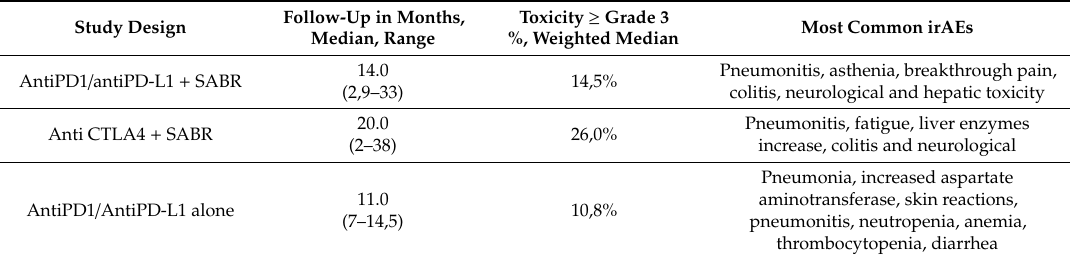
Table 2. Summary of Toxicity ≥ Grade 3 with RT-ICI combinations in